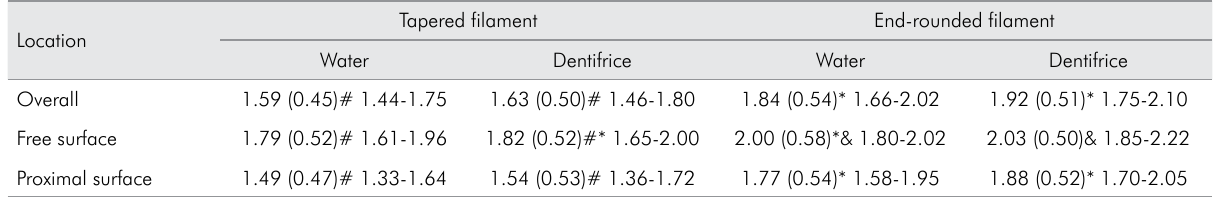
Table 3. Mean reduction of plaque (SD) and 95%CI according to the tooth surface location. Location